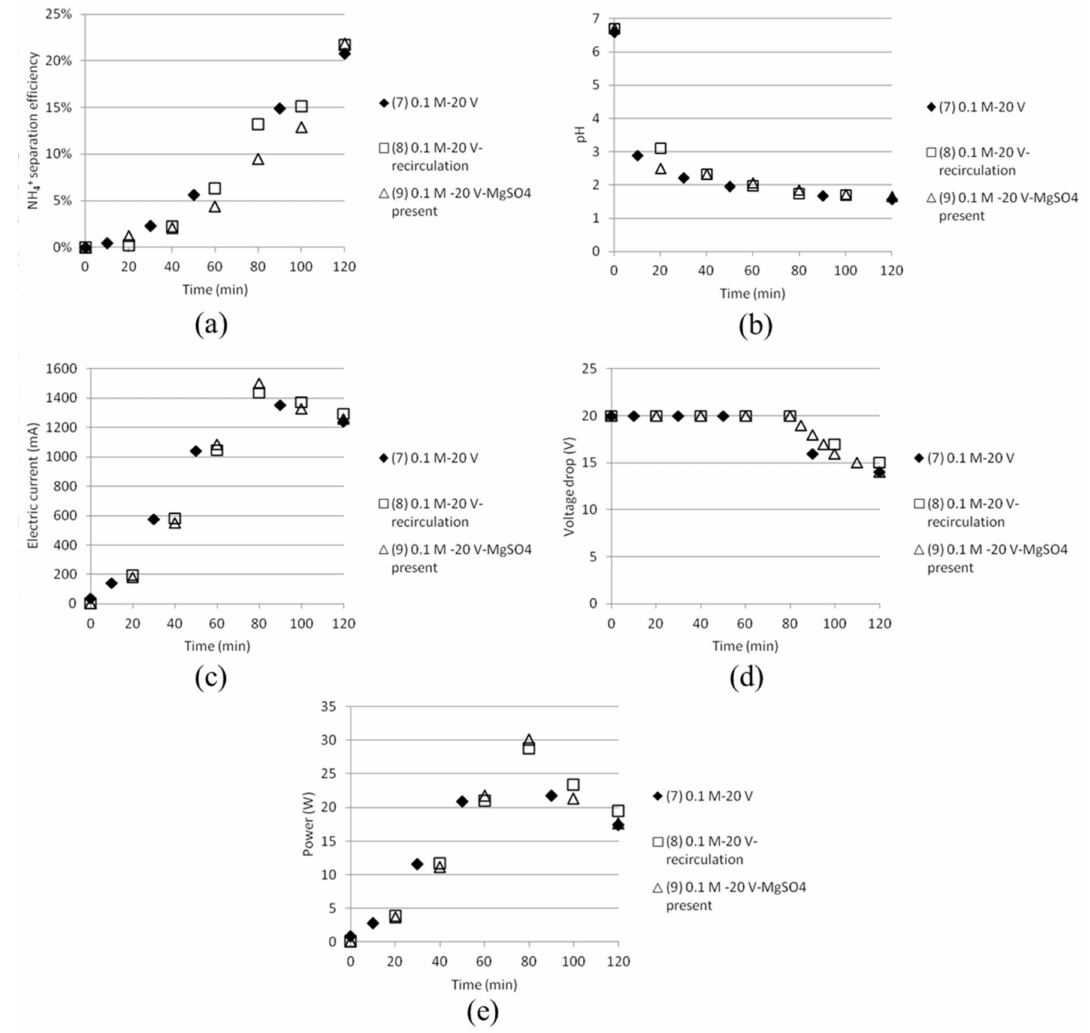
Figure 9. ( a ) NH 4 + separation efficiency; ( b ) pH; ( c ) electric current; ( d ) voltage drop and ( e ) power as function of time for tests done with double cell distance (80